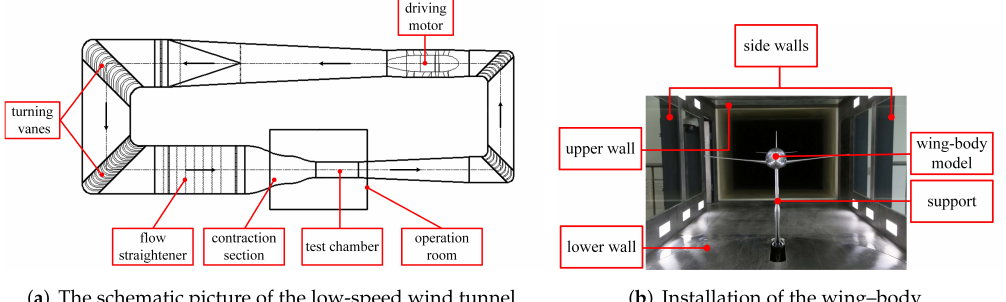
Figure 18. Experiment wind tunnel and